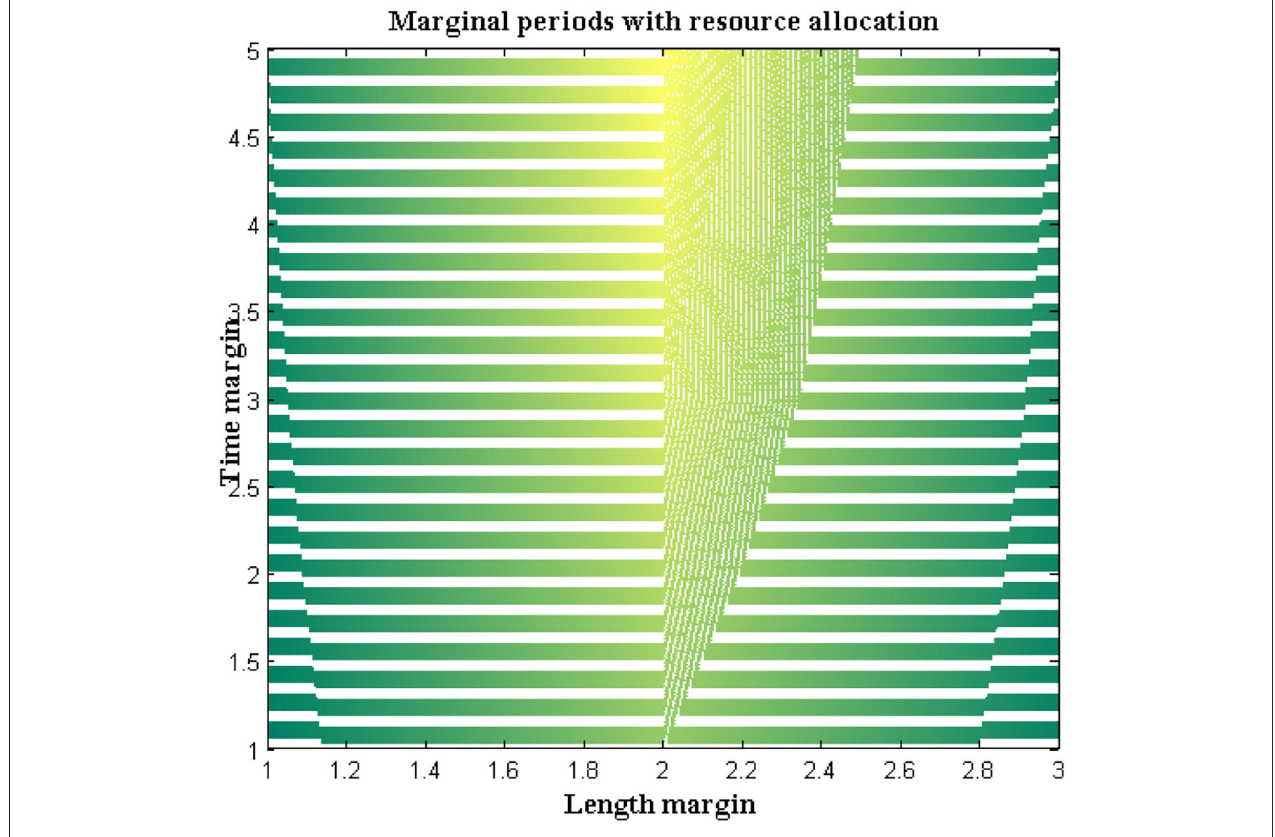
FIGURE 7 | Marginal periods with the allocation of resources.